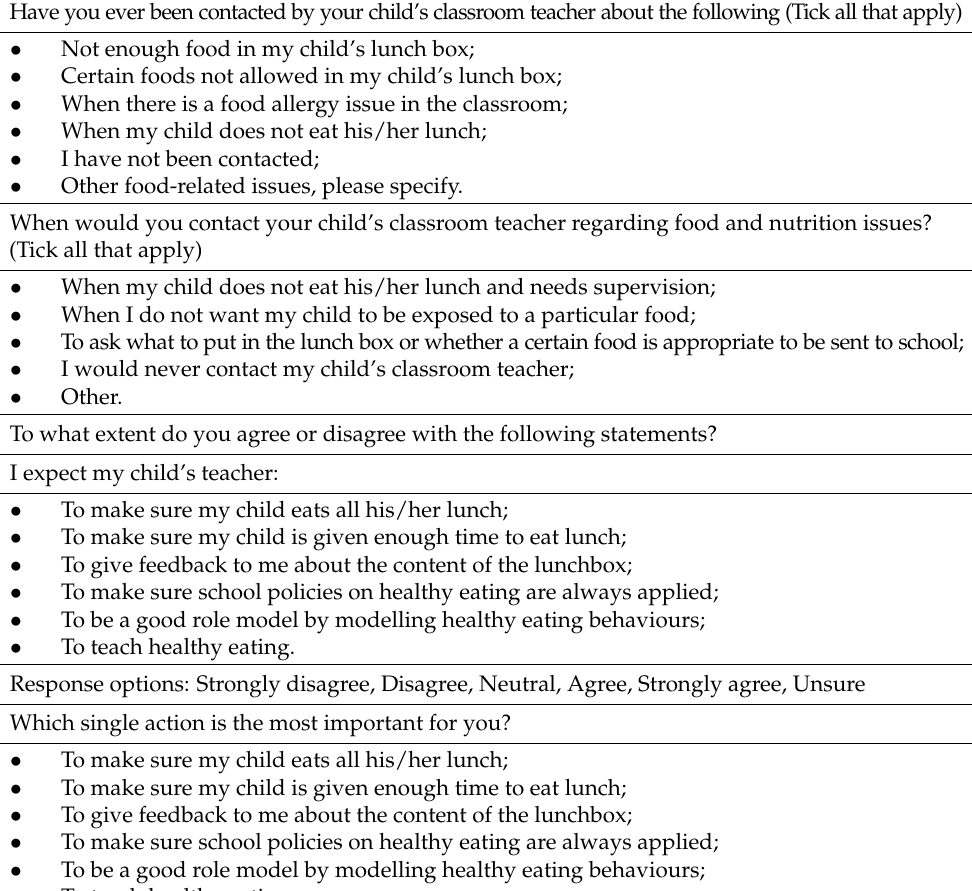
Table 1. Survey questions and response